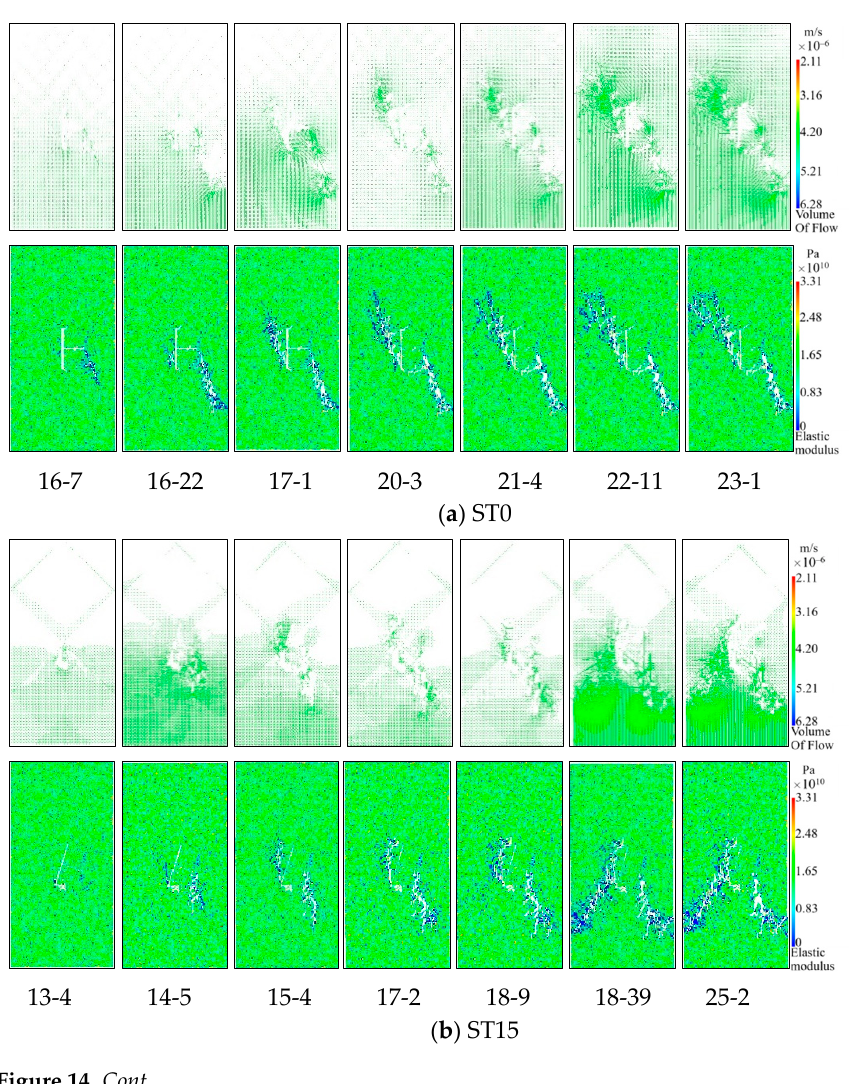
Figure 13. Comparison of permeability test and simulation results of ST0-ST90 specimens.